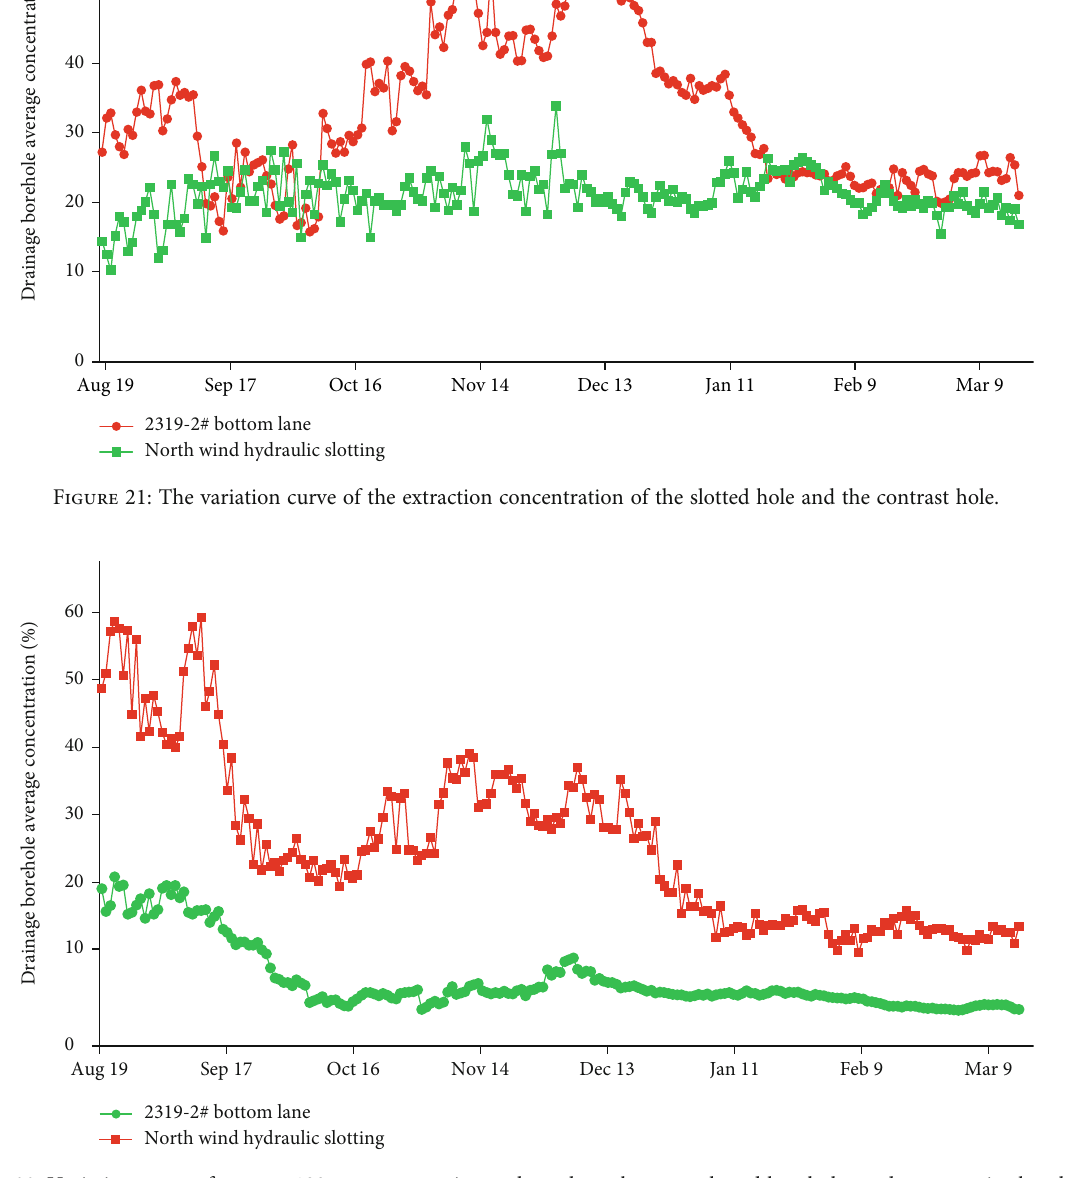
Figure 22: Variation curve of average 100-meter extraction scalar volume between slotted boreholes and comparative boreholes.